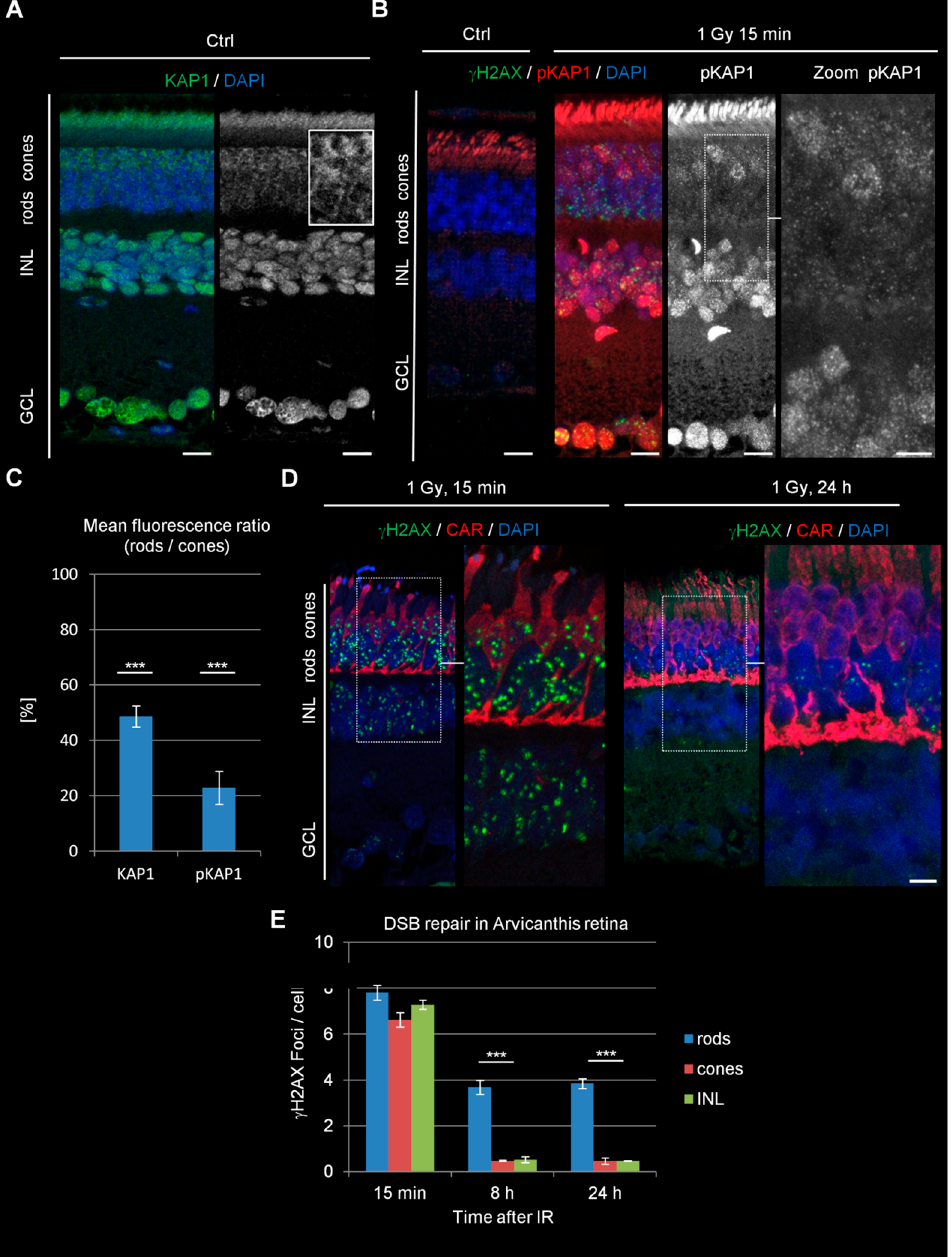
Figure 2. KAP1 expression, DSB signaling, and repair in retinae of adult Arvicanthis ansorgei. ( A ) Immunofluorescence images of KAP1 (green) in the retinae of adult Arvicanthis. Nuclei were counterstained with DAPI (blue). The box shows a higher magnification of rod and cone PRs. Scale bars represent 10 µ m. ( B ) Immunofluorescence images of IR-induced γ H2AX foci (green) and